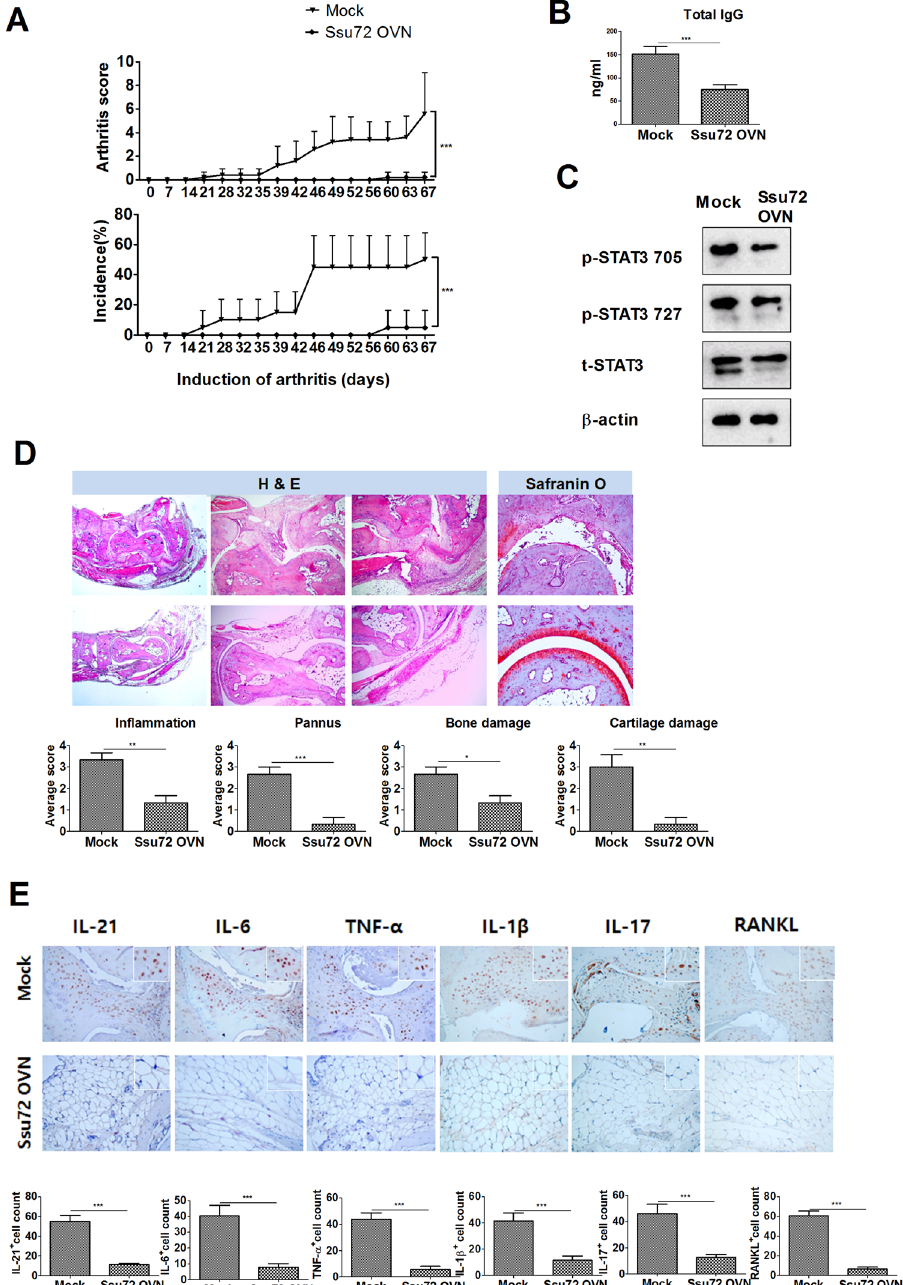
Figure 3. Ssu72 ameliorates the development of CIA. ( A ) The Ssu72 overexpression or mock vector was administered systemically to mice with CIA once per week. The clinical scores and incidence of CIA were measured in these mice ( *** P < 0.01, n = 10). ( B ) Total IgG levels were measured in each group ( *** P < 0.01, n = 10). ( C ) The levels of p-STAT3 Tyr705 and p-STAT3 Ser727 in splenocytes from mice with CIA (mock or Ssu72-overexpressing) that had been stimulated with IL-6 (20 ng/ml) for 1 h were examined by western blot analysis. ( D ) Joint tissues from mice with CIA were stained with hematoxylin and eosin (original magnification, 40 × or 200 × , n = 6) and Safranin O (original magnification, 40 × , n = 6). ( E ) Immunohistochemical staining was used to detect IL-6, IL-21, IL-17, IL-1 β , TNF- α and RANKL in the synovium of mice with CIA (mock or Ssu72-overexpressing; (original magnification, 200 × or 400 × , n = 6). The data represent the mean ± SD from three independent experiments. Statistical analyses were conducted using the nonparametric Mann-Whitney U -test ( * P < 0.05, ** P < 0.03, *** P <